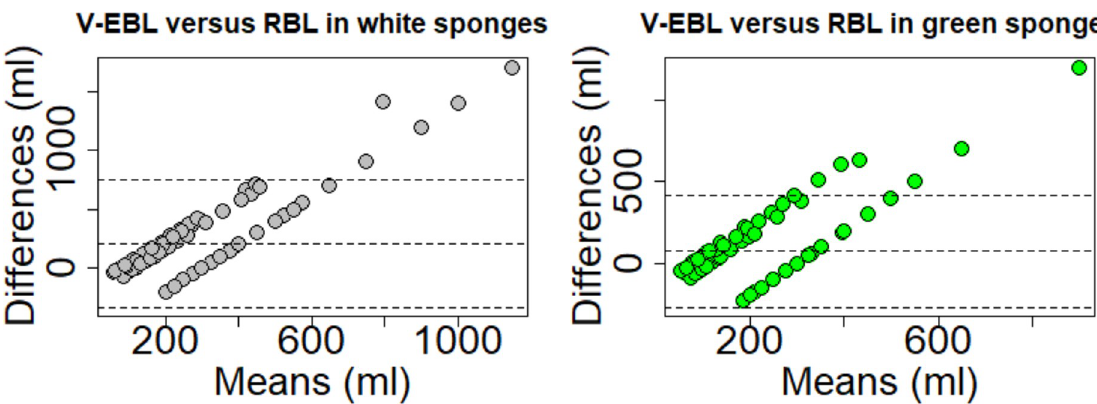
Fig 4. Bland-Altman plots for visually estimated blood loss (V-EBL). Bland-Altman plots for visually estimated blood loss (V-EBL) for white and green sponges compared to reference blood loss (RBL). The Bland Altman plot shows the mean differences (blue line) and agreement interval within 95% of the differences (lower: line; upper